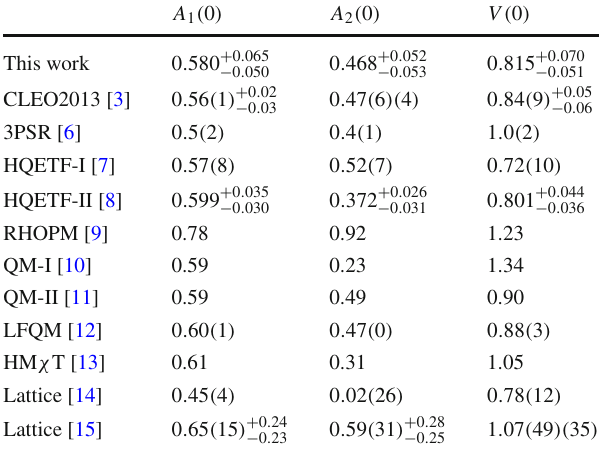
Table 3 The D → ρ TFFs A 1 , 2 ( q 2 ) and V ( q 2 ) at the large recoil region q 2 (cid:9) 0. The errors are squared averages of all the mentioned error sources. As a comparison, we also present the prediction from various